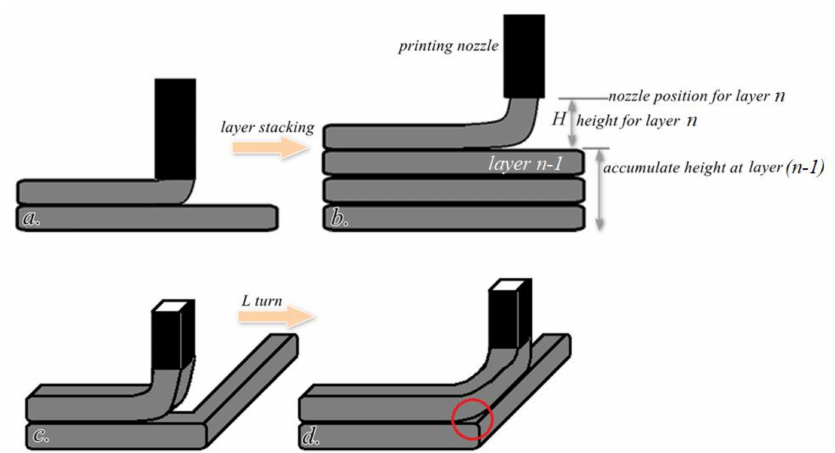
Figure 6. The layer stacking process. ( a ) A typical layer-stacking operation, ( b ) the layer stacking with reserved height H, ( c ) an L-turn for layer stacking operation with GHT, and ( d ) inaccurate filament